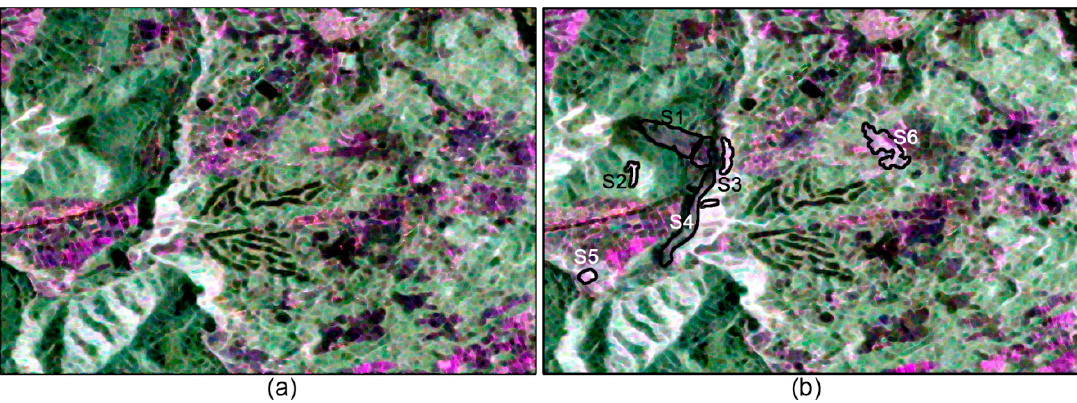
Figure 2. PALSAR-2 images (red: HH; green: HV; blue: VV) of the study area acquired ( a ) before and ( b ) after the earthquake. Manually selected six landslide regions of interest are marked in black.